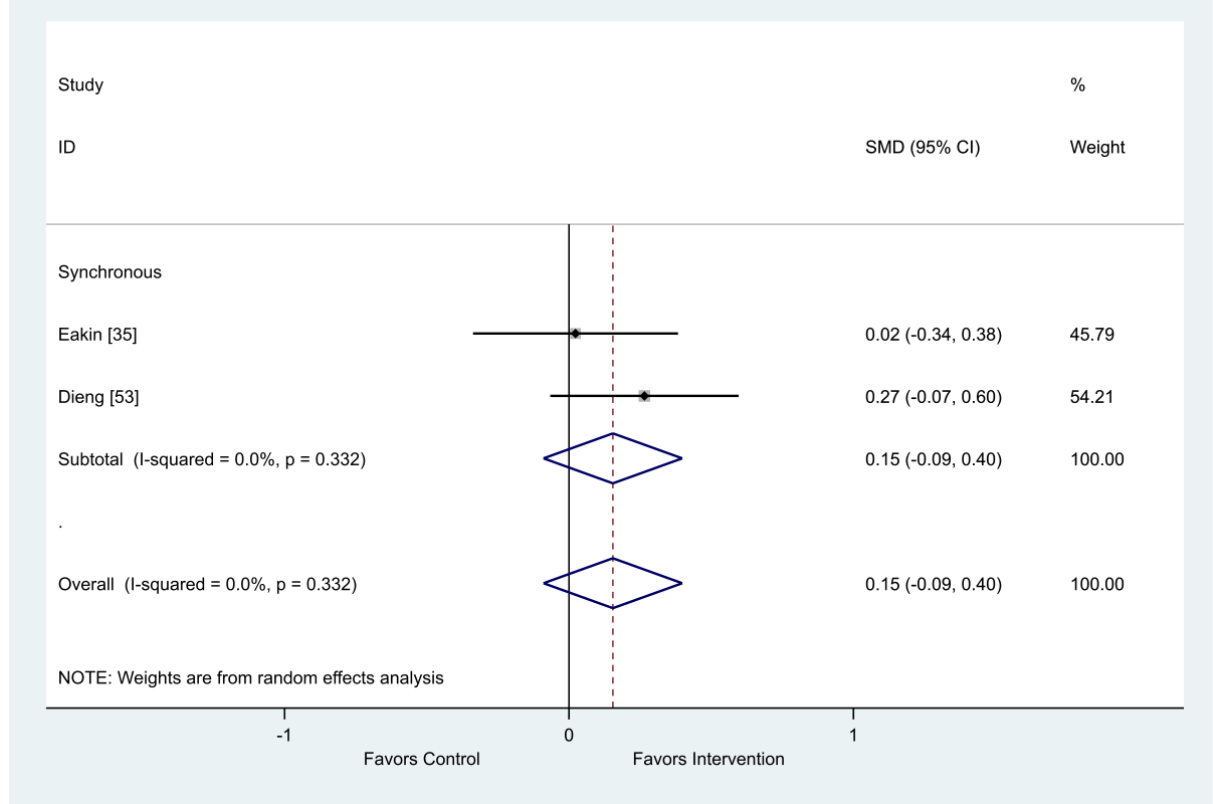
Figure 12. Effect of electronic health interventions with a control on anxiety interventions, analyzed using standardized mean difference (postintervention mean and SD change scores). Lower scores indicate improved anxiety. SMD: standardized mean difference.